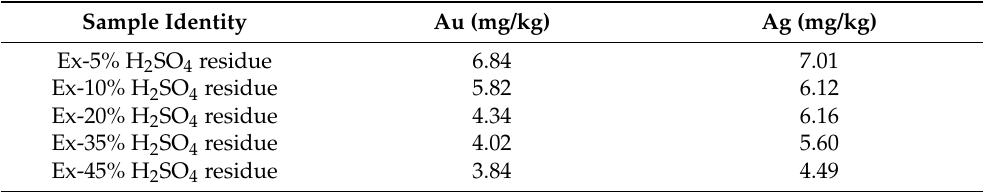
Table 12. Cyanidation stage: Au and Ag in residue